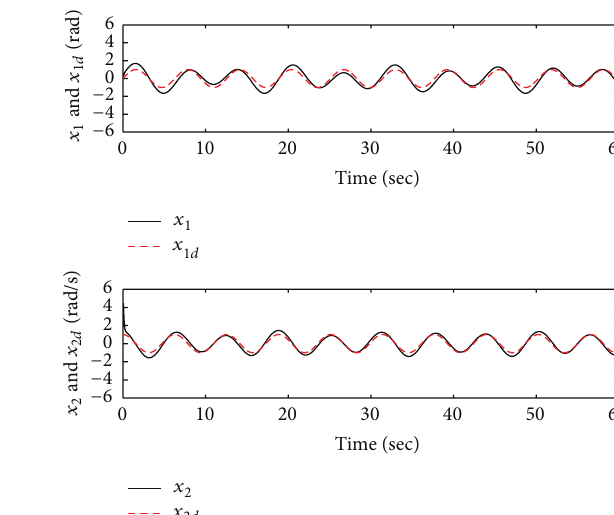
Figure 10: The tracking performances of 𝜃 and